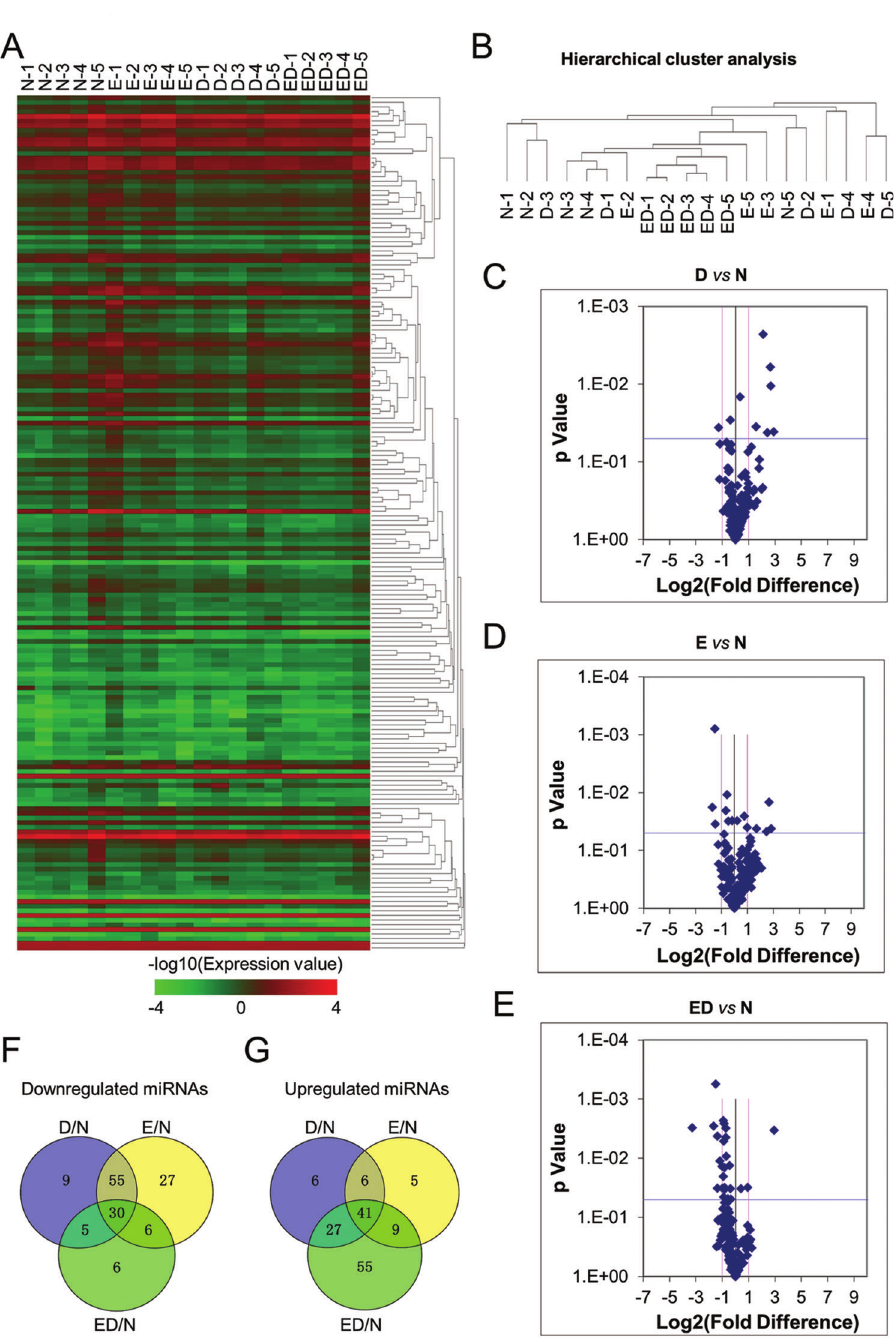
Figure 2 - Comparation of plasma miRNA expression profile among patients and healthy donors. A Heatmap assay of the differentially expressed miRNAs in plasma samples of healthy donors (N-1, N-2, N-3, N-4, N-5), patients with essential hypertension (E-1, E-2, E-3, E-4, E-5), type 2 diabetes (D-1, D-2, D-3, D-4, D-5), patients with essential hypertension and type 2 diabetes mellitus (ED-1, ED-2, ED-3, ED-4, ED-5). B Hierarchical cluster analysis of plasma miRNA expression profile among patients (E, D, ED) and healthy donors (N). C-E The scatter plots illustration of differentially expressed miRNAs between the D and N groups ( C ), E and N groups ( D ), and ED and N groups ( E ). F-G Venn Map analysis of the distributions of the differentially downregulated ( F ) or upregulated ( G ) miRNAs in plasma samples among the indicated groups (N, E, D, and However, to distinguish from the other candidate miRNAs (Figure 3A-3D, Figure S3A-S3B). For instance, miR-197-3p (miR-197-3p, miR-130a-3p, and miR-27a-3p), only miR-195- was only differentially downregulated in patients with ED, 5p was also downregulated in the E and D groups. Above whereas miR-130a-3p and miR-27a-3p revealed the opposite all, miR-195-5p expression in patients with EH and T2DM trend in E and D groups, respectively (Figure 3A-3C).